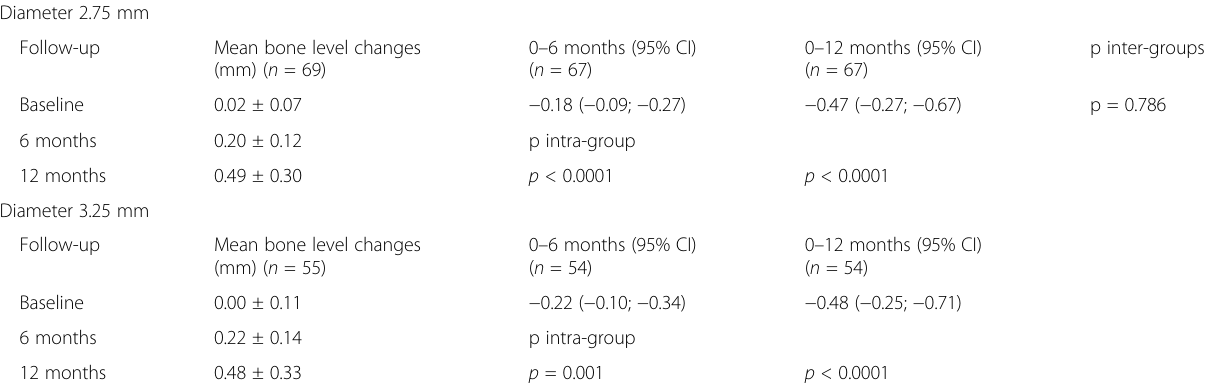
Table 4 Comparison of mean bone levels (means ± SD) at different follow-up intervals in different implants diameters groups (2.75 and 3.25